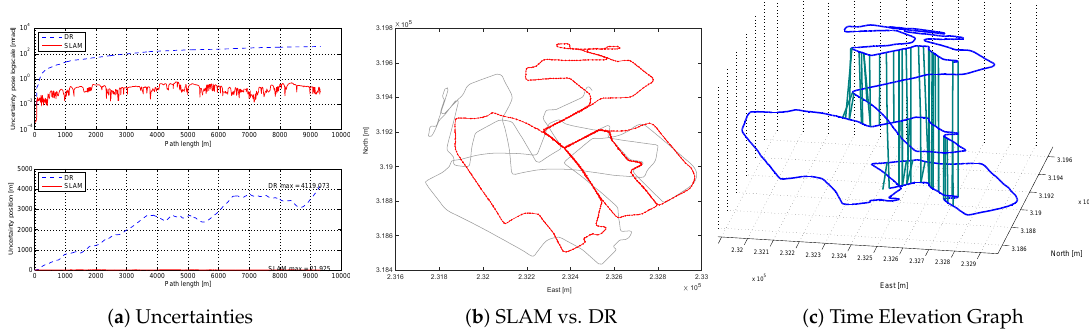
Figure 13. Proposed digital map-based SLAM results. ( a ) Uncertainty versus path length . Whereas the uncertainty of DR navigation (blue, dot) shows unbounded growth, the uncertainty of SLAM (red solid) is bounded from wall-to-wall loop closures. The graph at the top of the pose uncertainty with log-scale of y axis (unit: m · rad. The following [53–55], we use m · rad to show pose uncertainty), the bottom graph shows the position uncertainty (unit: m). ( b ) Top-down view of the SLAM estimate (red line) versus dead-reckoning trajectory (gray line). ( c ) The xy component of the SLAM trajectory estimate is plotted versus time, where the vertical axis represents mission time. Green lines show wall-to-wall matching for loop closure.